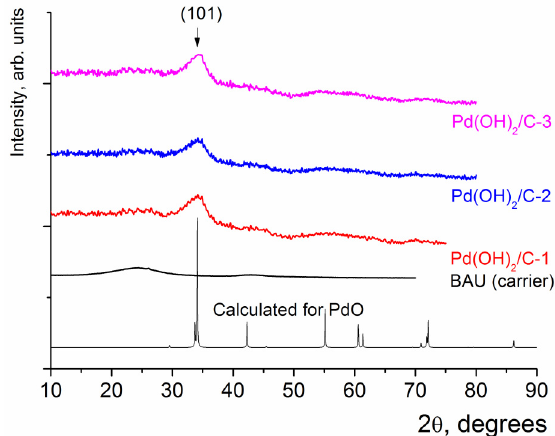
Figure 6. XRD patterns of Pd(OH) 2 /C composites.